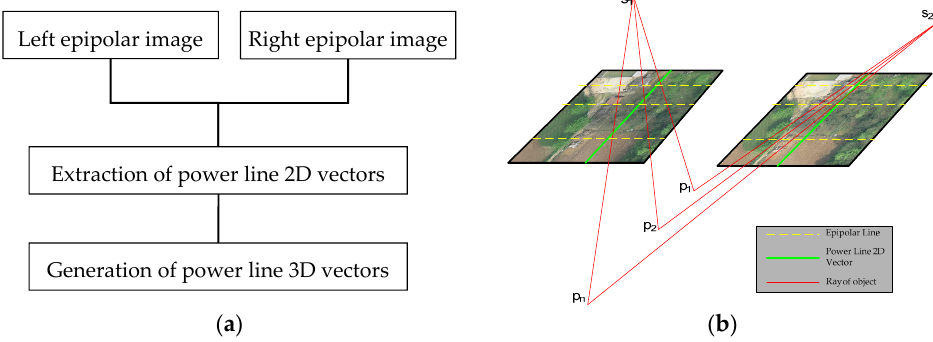
Figure 3. Schematic diagrams of the automatic power line measurement method. ( a ) Flow chart for the power line automatic measurement method based on epipolar constraints (PLAMEC); ( b ) Visualization of the PLAMEC.